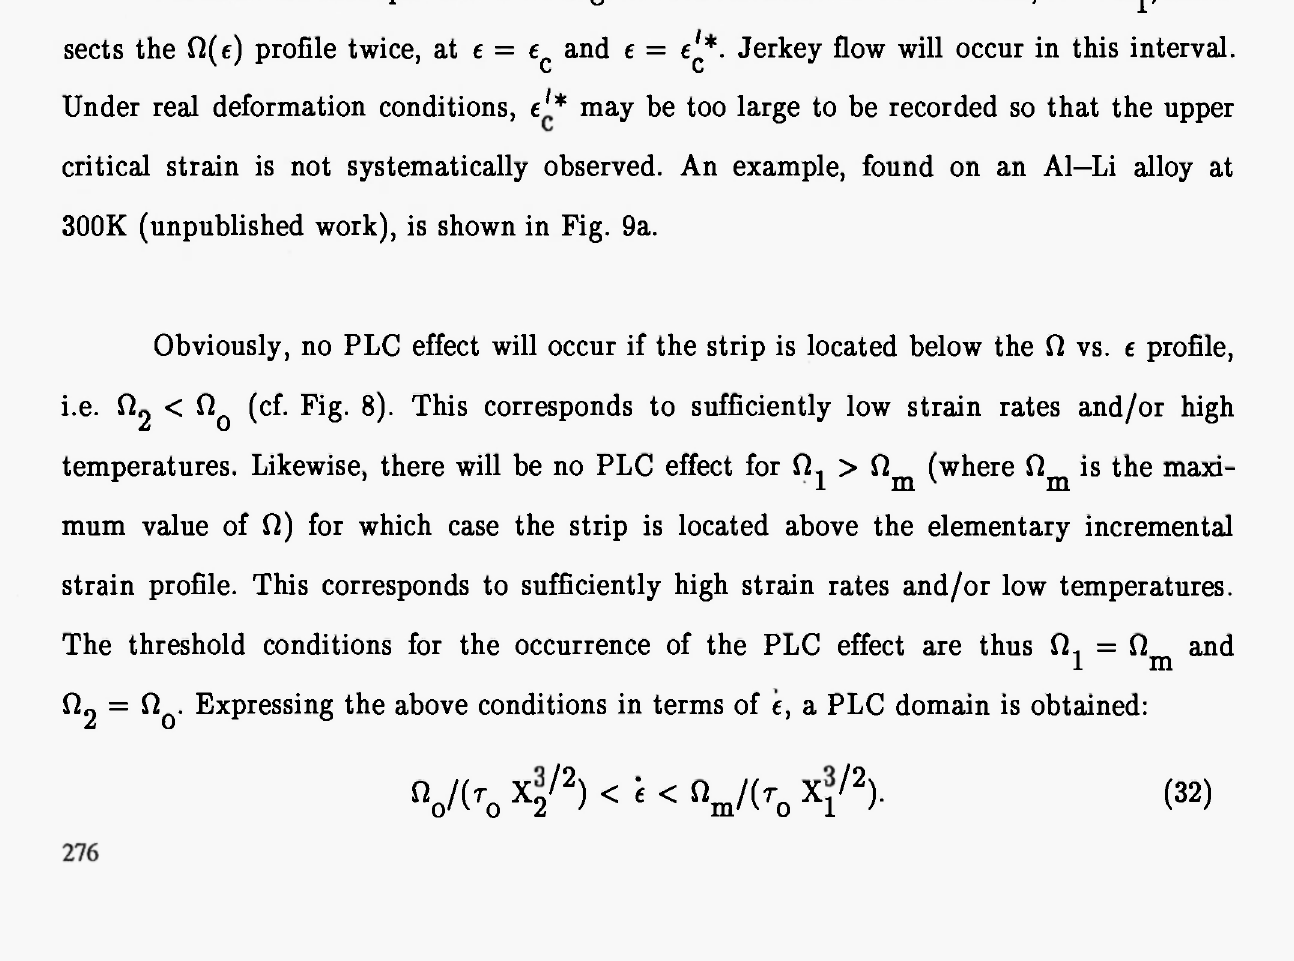
Fig. 8. Elementary incremental strain Ω as a function of e. Ω the initial, the maximum, and the saturation values, respectively. The negative SRS range (i.e. the PLC domain) is represented by the hatched strip bounded by the horizontal lines Ω = Ωι and Ω = Ω and upper (e '*) critical strains are c